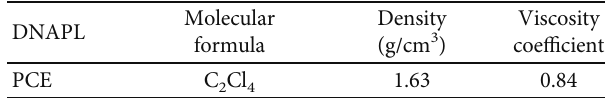
Table 1: Characteristics of